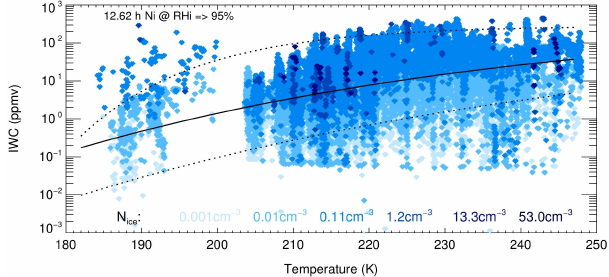
purpose, we used only measurements where RH ice > 95 %.